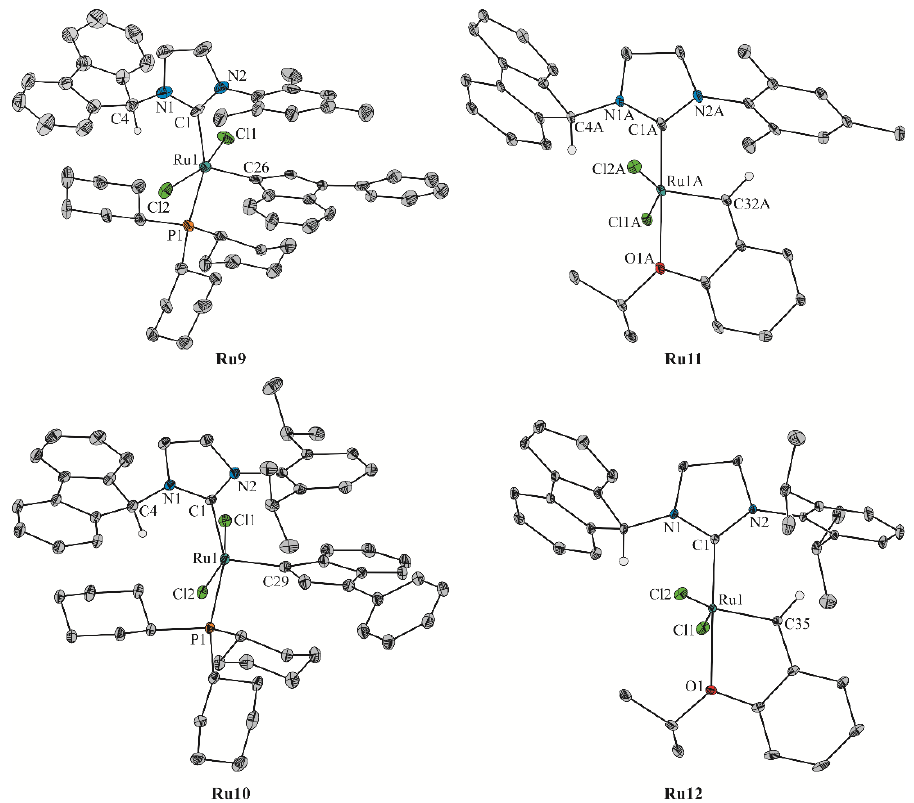
Figure 3. Molecular structures of the Ru9–Ru12 complexes. Displacement ellipsoids are drawn at the 50% probability level. All hydrogen atoms, except those attached to the C4/C4A and C32A/C35 atoms, as well as the second independent molecule B of Ru11 and the solvent molecules were omitted for clarity.